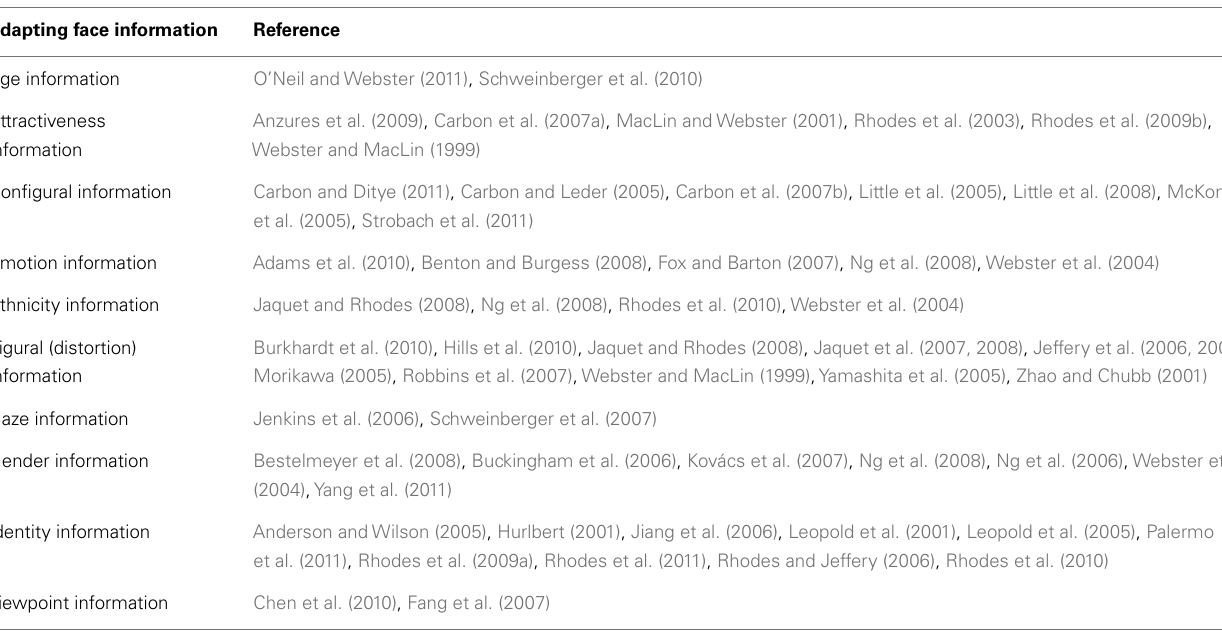
Table 1 | Overview of types of adapting face information and related